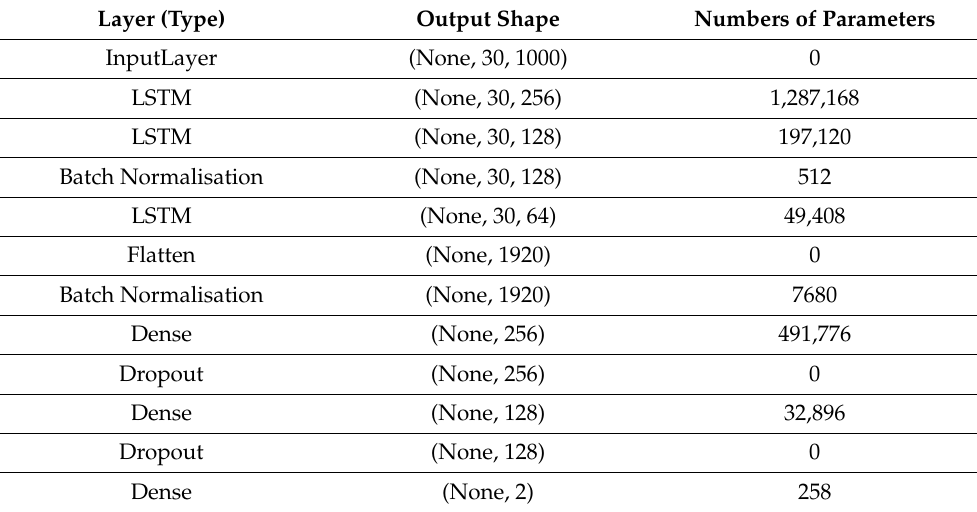
Table 4. Detailed summary of the spatial-temporal model for abnormal activity